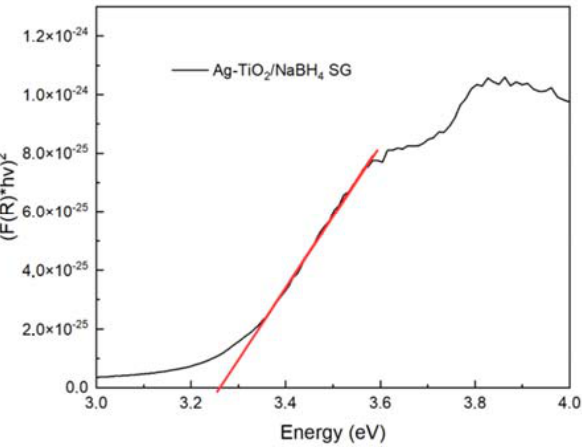
Figure 9. Tauc plot of NaBH 4 /Ag-TiO 2 SG material.